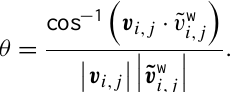
Fig. 2. Bering Glacier system longitudinal velocity profile (location in Fig. 1). Dates of image pairs are denoted by the colored boxes in the timeline. The width of each box indicates the length of the inter- val; heights of the boxes are for visual clarity only. Colors gradually darken as time moves forward each winter. Thin colored boxes be- low the timeline show dates of altimetry intervals in Figs. 5 and 6. BGS velocities in January 1994, during previous surge, are shown as grey data line. The location of the trigger zone for first stage is indicated by the grey